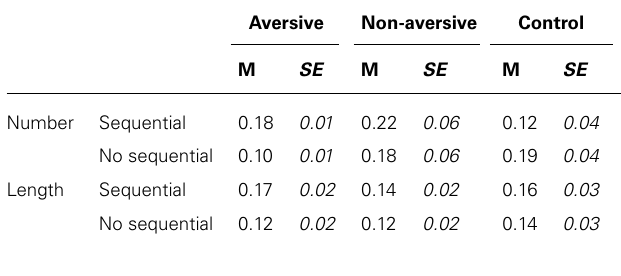
Table 1 | Mean and standard error ofWeber ratios for the number and the length bisection in the sequential and the non-sequential presentation for the aversive, non-aversive and control